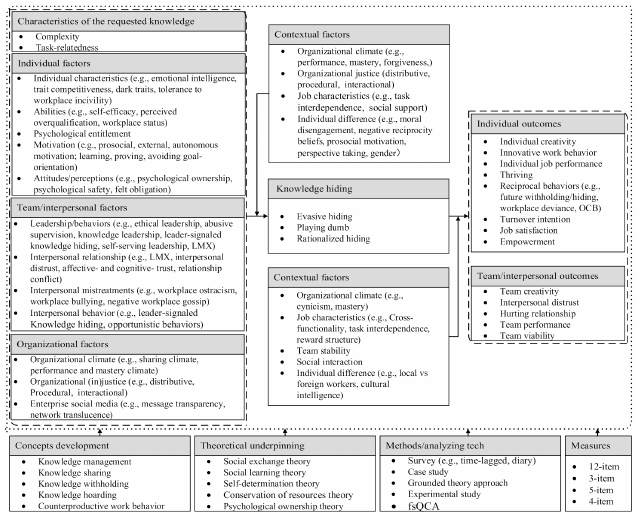
Figure 6. A framework of knowledge-hiding research according to content analysis.